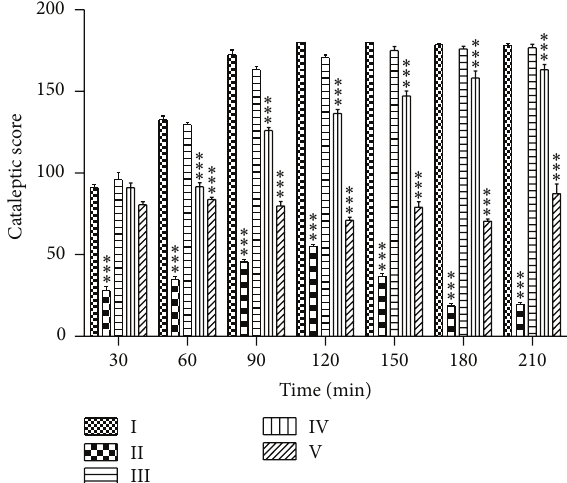
Figure 1: Effect of PEFRE on haloperidol induced catalepsy in rats. Group I: vehicle control group; Group II: Levodopa + haloperidol treated group; Group III: PEFRE (100 mg/kg) + haloperidol treated group; Group IV: PEFRE (200mg/kg) + haloperidol treated group; Group V: PEFRE (400mg/kg) + haloperidol treated group. ∗∗∗ 𝑝 < 0.001 as compared to Vehicle treated control